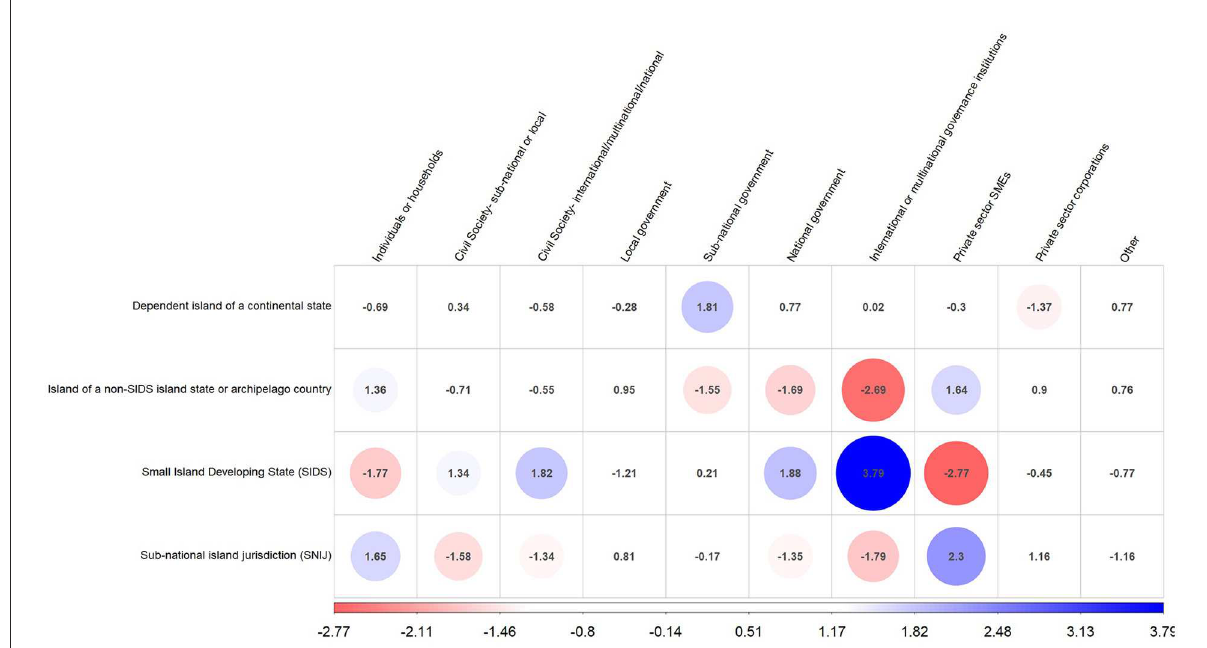
FIGURE8 Political status of islands related to actors. Results of the chi-square test calculating the residuals, that is, the difference between the observed and the expected frequency of each combination of political status and actor type, are shown. Residuals below − 2 and above 2 can be considered significant. Positive residuals (blue) indicate a higher observed frequency of an actor-role combination, and negative residuals (red) indicate a lower than expected frequency. The size of the circles corresponds to the value of the residuals. X -squared = 84.366, df = 27, p -value = 8.097e −